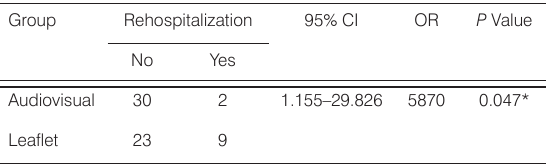
Table 3. The difference in rates of rehospitalization cases (N =